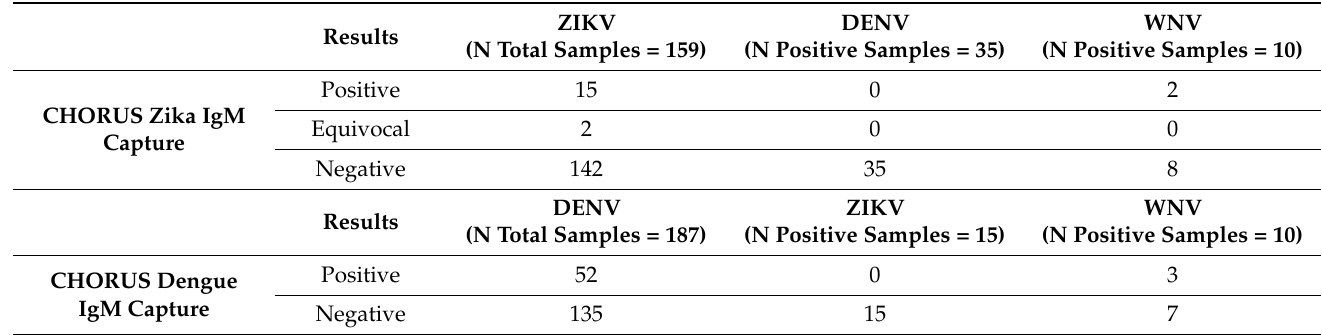
Table 3. Specificity of the CHORUS Zika and Dengue IgM Capture assays.